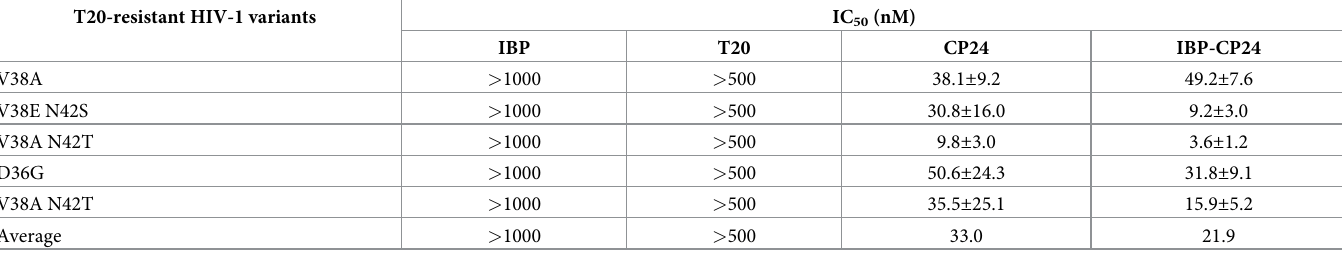
their viability with CCK-8. As shown in Fig 4A and 4B, IBP-CP24 showed no significant in vitro cytotoxicity to MT-2 and M7 cells at the concentration as high as 5 μ M, more than 800-fold higher than its IC for HIV-1 inhibition. Similarly, both IBP and CP24 at 5 μ M 50 showed no in vitro cytotoxicity to MT-2 and M7 cells (Fig 4A and 4B). To investigate the potential in vivo toxicity of IBP-CP24, ICR mice were administered with PBS, 10 mg/kg CP24 in PBS, 10 mg/kg IBP-CP24 in PBS, or 100 mg/kg IBP-CP24 in Table 4. Inhibitory activity of IBP, T20, CP24, and IBP-CP24 against T20-resistant strains. T20-resistant HIV-1